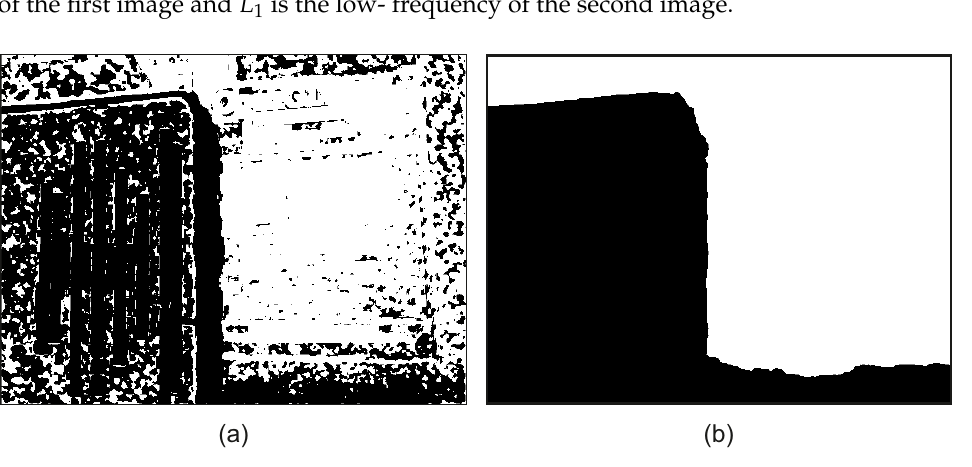
Figure 6. Predicted labels, black pixels correspond to (cid:96) = 0, white pixels correspond to (cid:96) = 1, ( a ) (cid:96) = argmin U , ( b ) (cid:96) = argmin ( CRF )